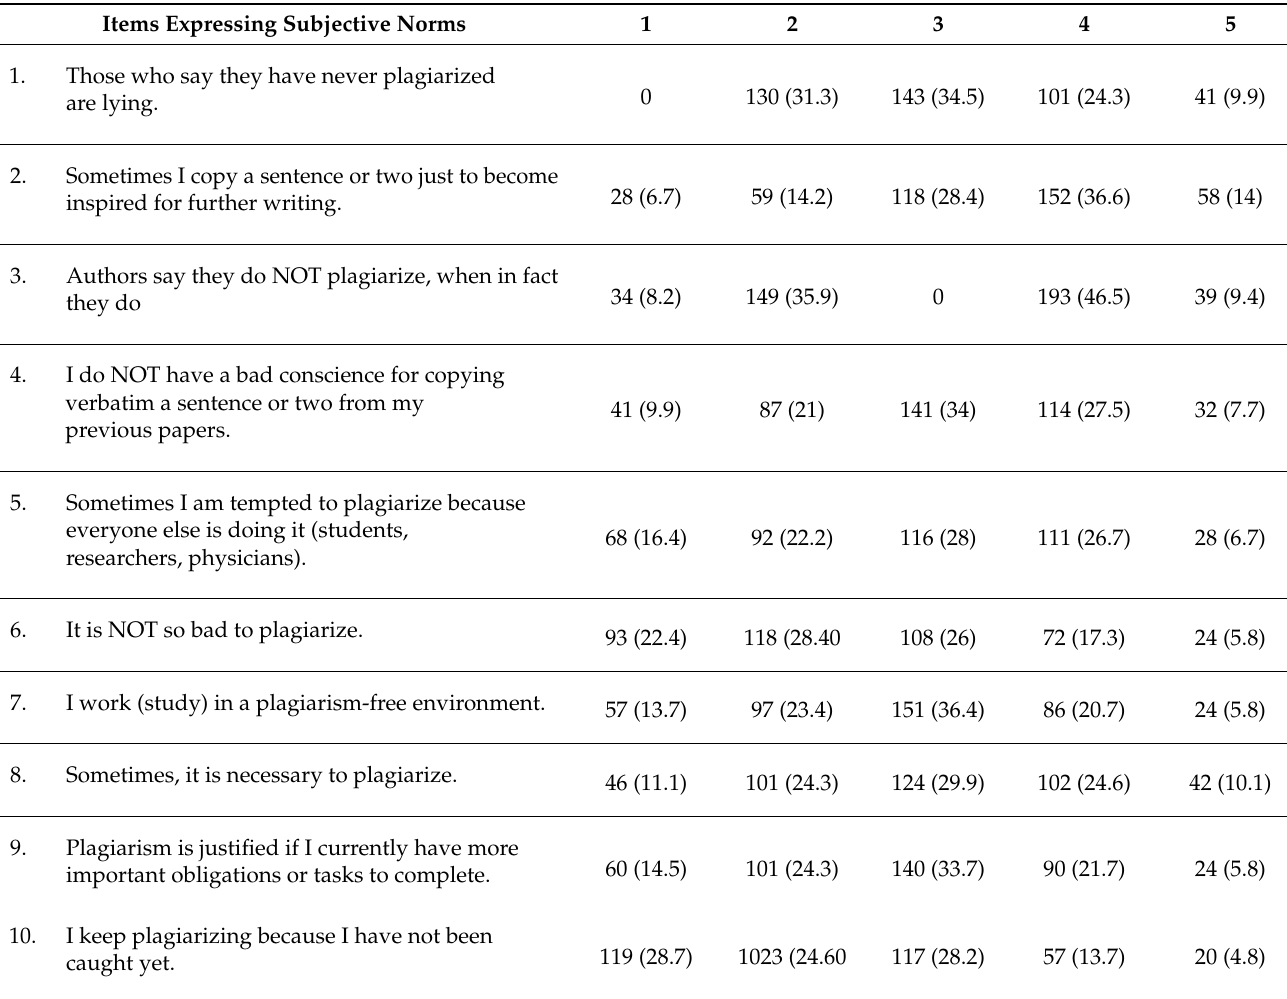
Table 5. Distributions of responses to the subjective norms attitude toward plagiarism questionnaire (N =